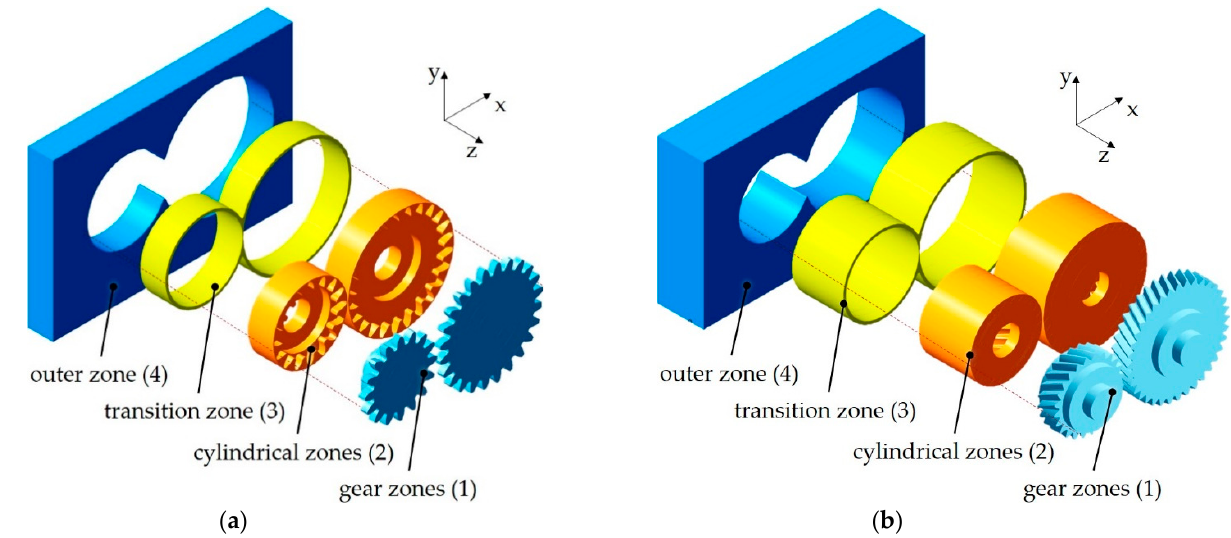
Figure 2. Modular structure of the geometry model for gear-C ( a ) and gear-LL ( b ).